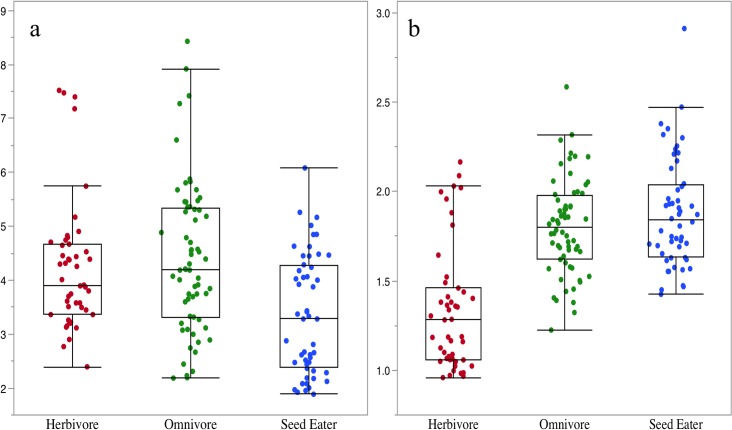
OD/DE (a) and BD/MD (b) of specimens used in the QDA model by dietary category. (a) Seed eaters have thicker enamel caps relative to their occlusal surfaces. Kruskal-Wallis, p<0.0001. Steel-Dwass all pairs comparisons: Herbivore-Omnivore, p = 0.6697; Herbivore-Seed Eater, p = 0.0025, Omnivore-Seed Eater, p = 0.0001. (b) Herbivores have relatively broader incisors. Kruskal-Wallis, p<0.0001. Steel-Dwass all pairs comparisons: Herbivore-Omnivore, p<0.0001; Herbivore-Seed Eater, p<0.0001, Omnivore-Seed Eater, p = 0.5249.